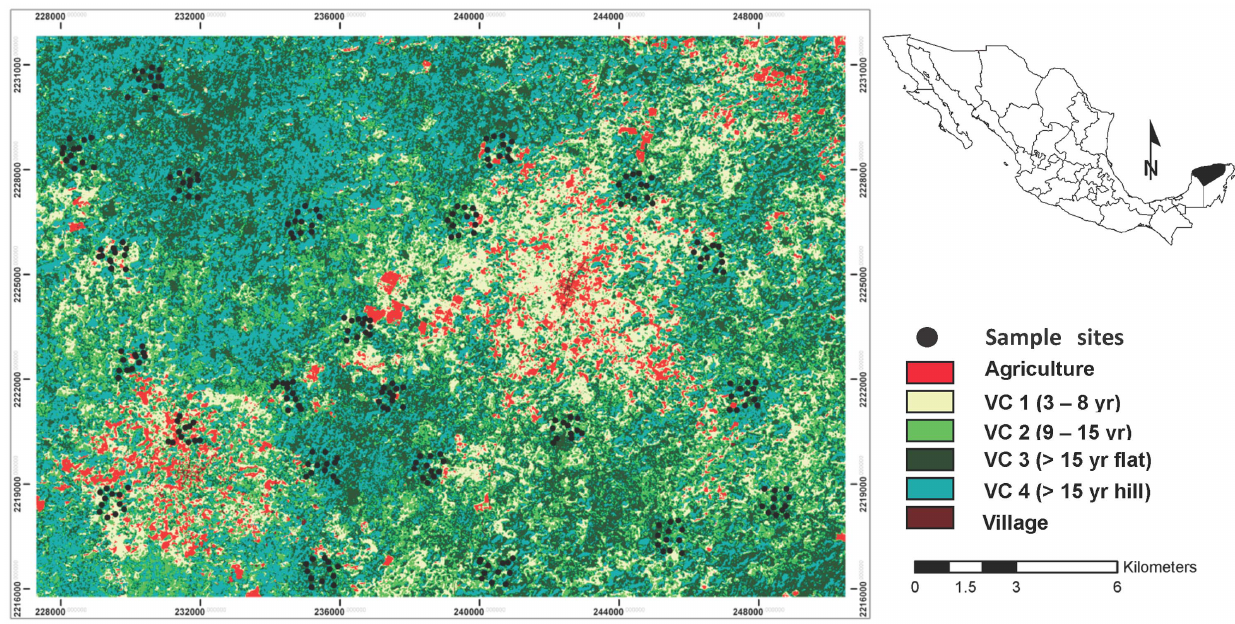
Figure 1. Location and land-cover thematic map of the study area showing the location of sampling sites.